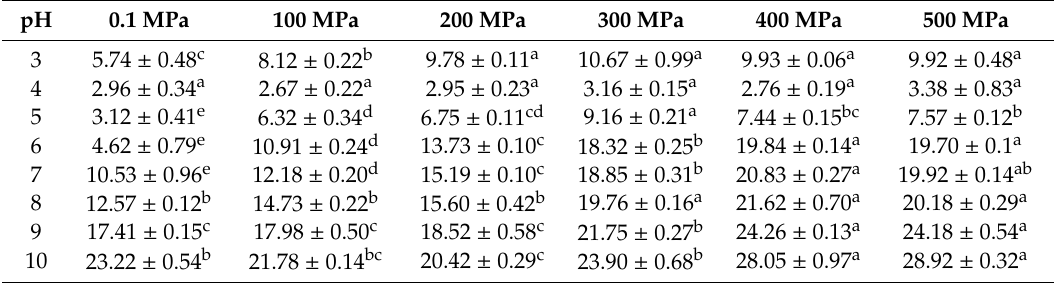
Table 1. Protein solubility of control and HP treated oyster proteins under di ff erent pH